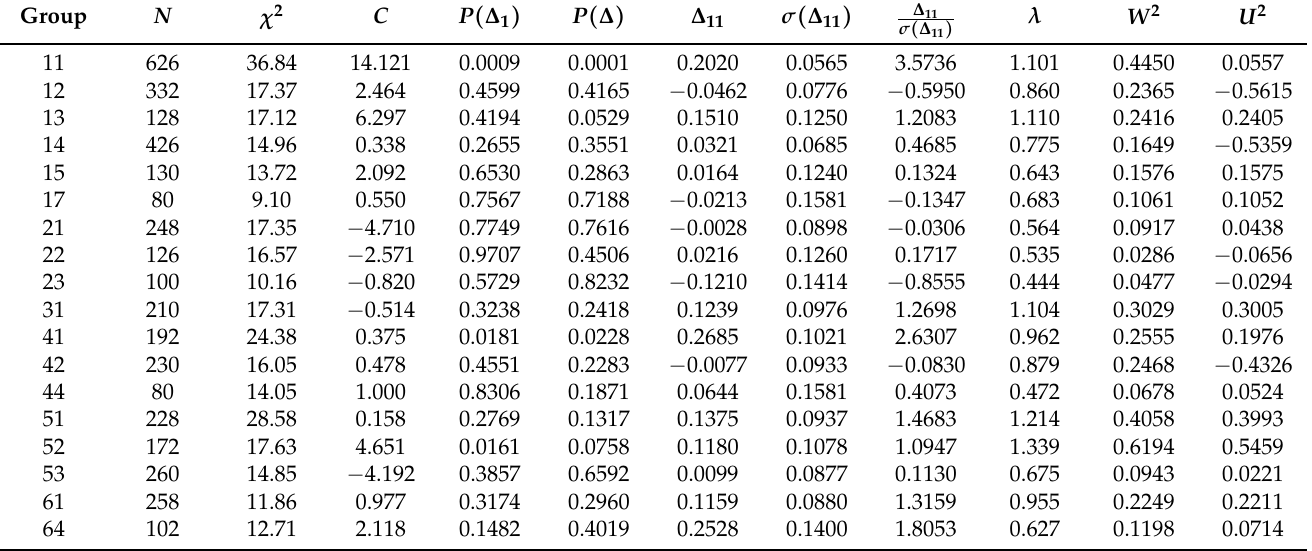
Table 14. Test for isotropy of the orientations of the galaxy plane. The distribution of the angle η was calculated with q 0 depending on the morphological type and Fouque and Paturel